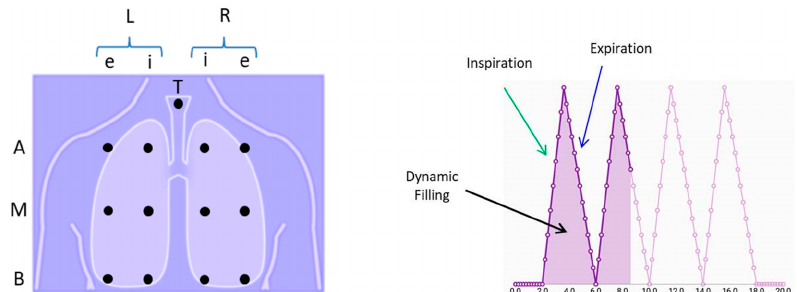
Figure 4. Auxiliary activities for the acquisition of respiratory sounds in the developed app. Left : In the mobile screen an array of possible acquisition locations appears to associate a name to the acquired sound. Right : a second screen is shown by the app where the respiratory maneuver with dynamic filling provide a visual guidance to the physician and patient about the inspiration and expiration